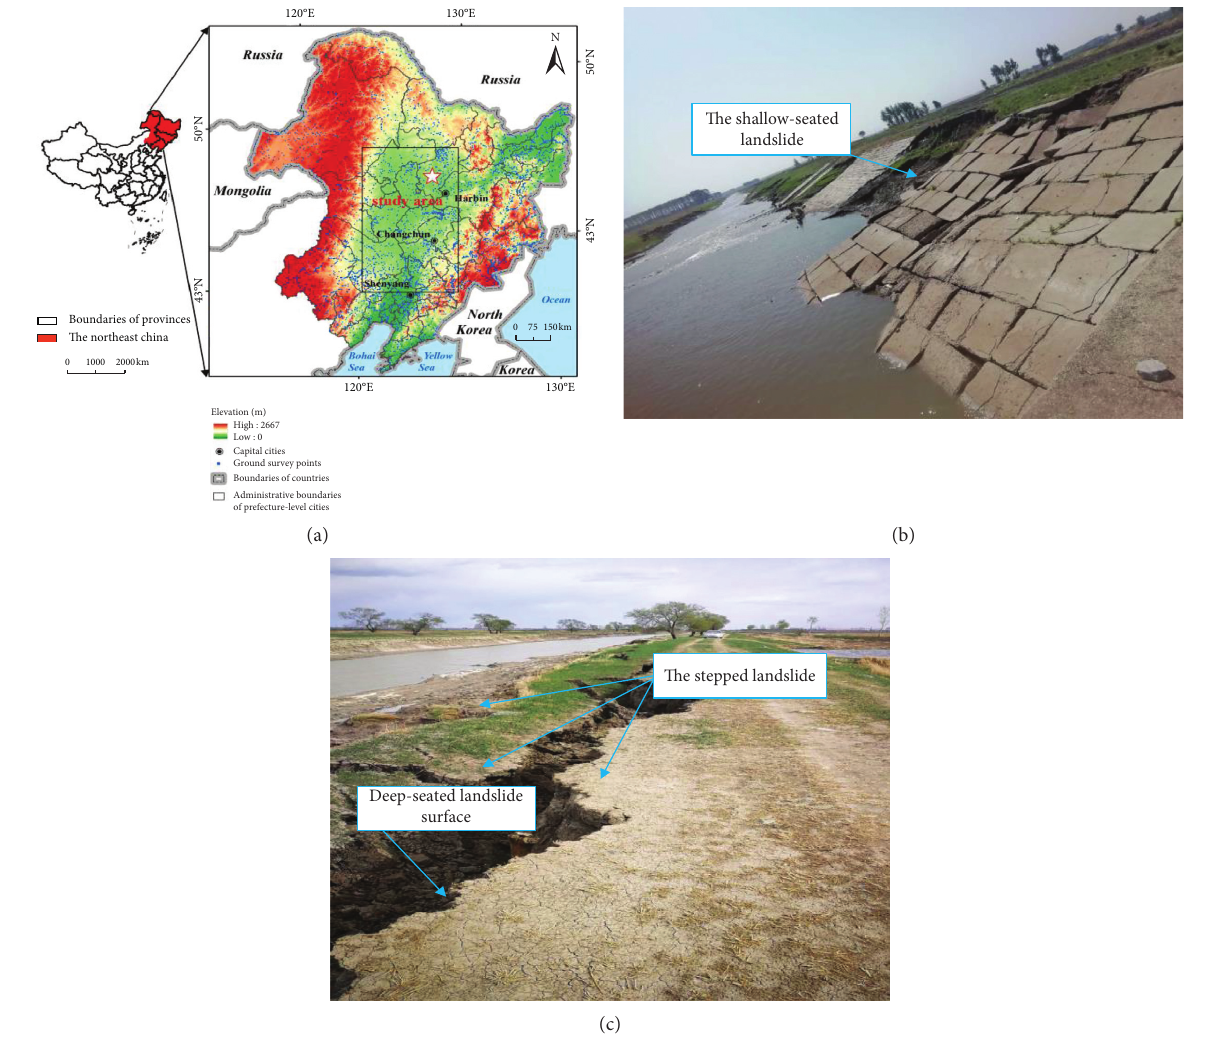
Figure 2: Types of landslides of dispersive soil slopes (Daqing City, Northeast China). (a) Area and location of the site of destruction (Daqing City, Northeast China), (b) shallow-seated landslide of dispersive soil, and (c) deep-seated landslide of dispersive soil. Table 1: The rivers and channels damaged by landslide failure of dispersive soil slopes. Location Name of rivers Rivers length